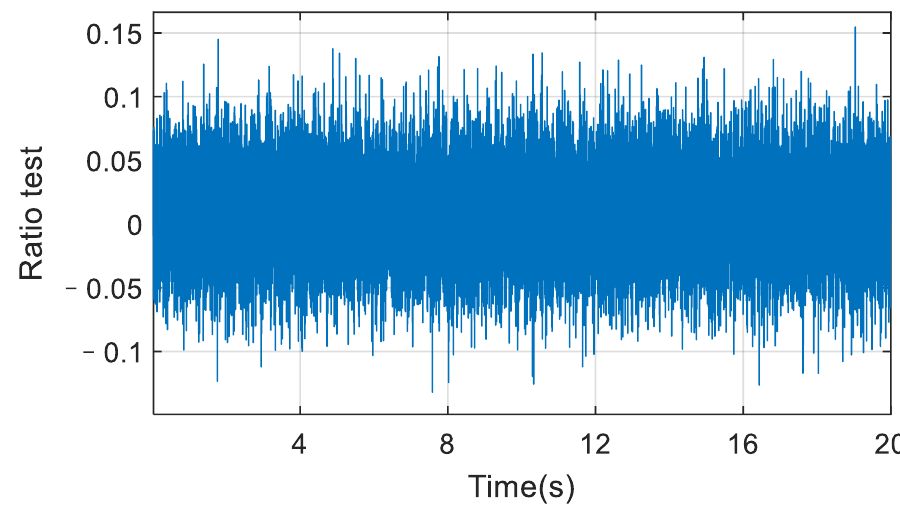
Figure 21. Ratio Test metric behavior of the genuine signal.